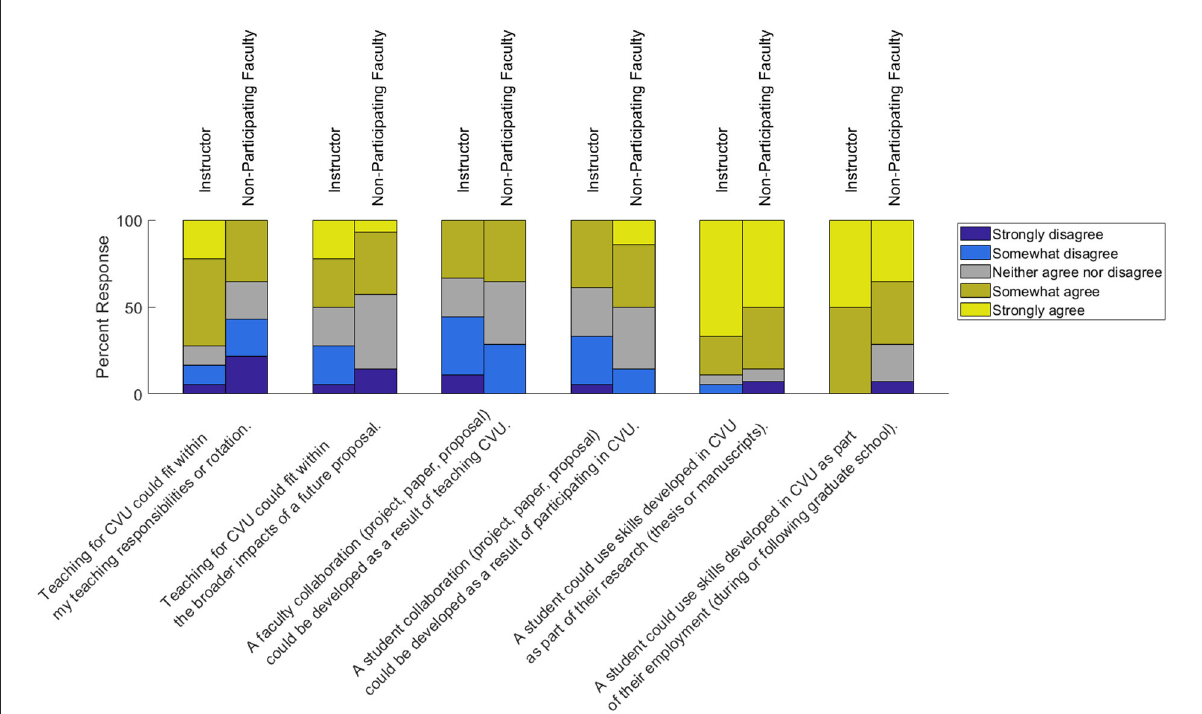
FIGURE3 Levels of agreement to statements about outcomes from CVU participation for students and faculty. Instructors were asked to recall their perceptions prior to their first participation.